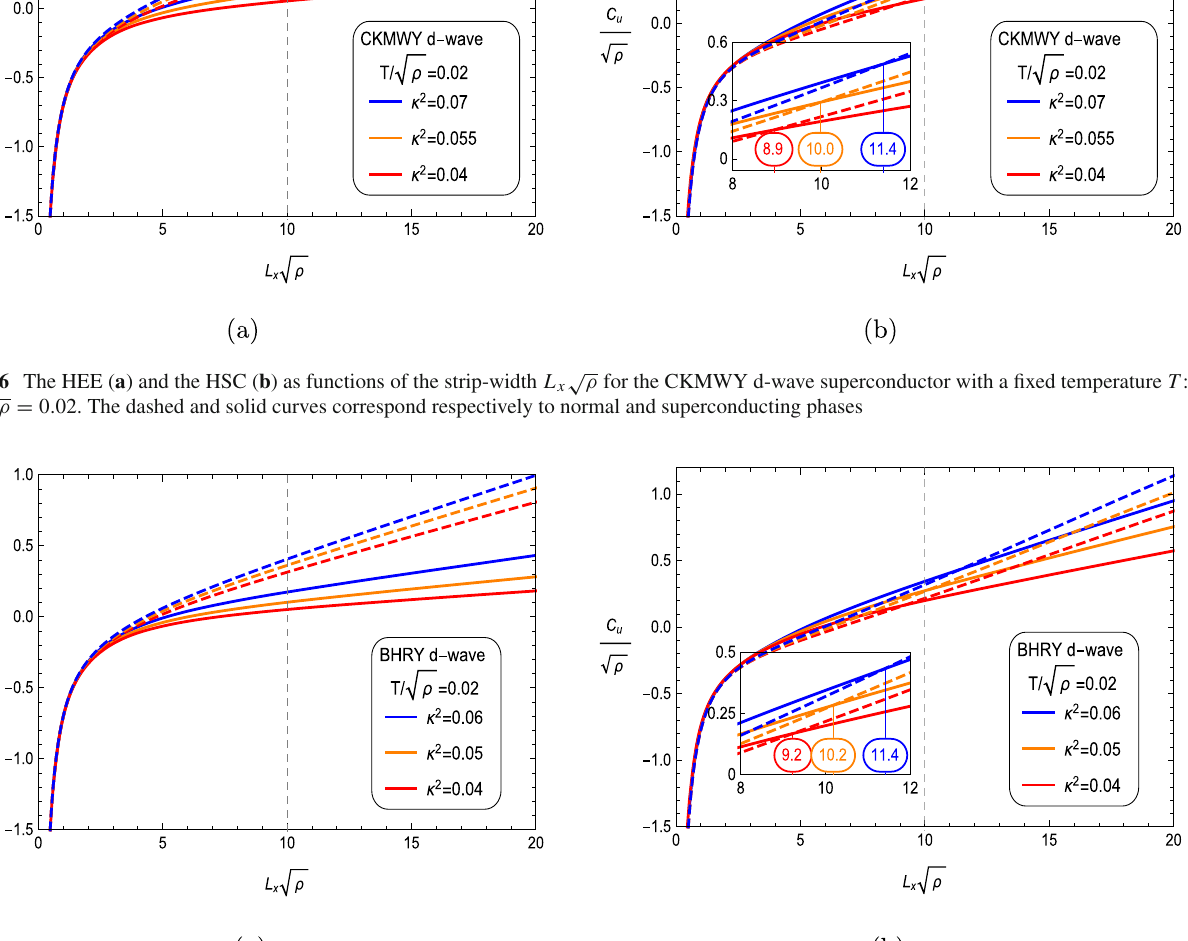
Fig. 7 The HEE ( a ) and the HSC ( b ) as functions of the strip-width L x √ ρ = 0 . 02. The dashed and solid curves correspond respectively to normal and superconducting T /